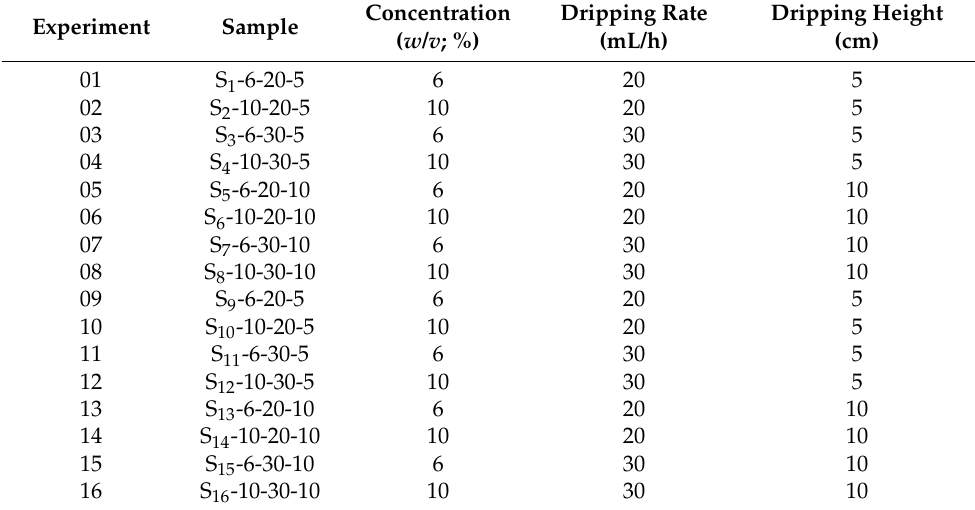
Table 2. Representation of variables and parameters used in triplicates for obtaining the spheres. Concentration Experiment Sample